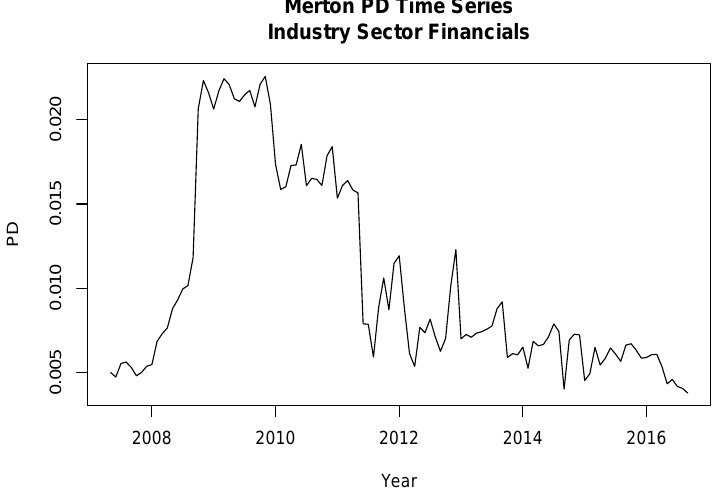
Figure 1. Exemplary plot of the mean probability of default in the industry sector